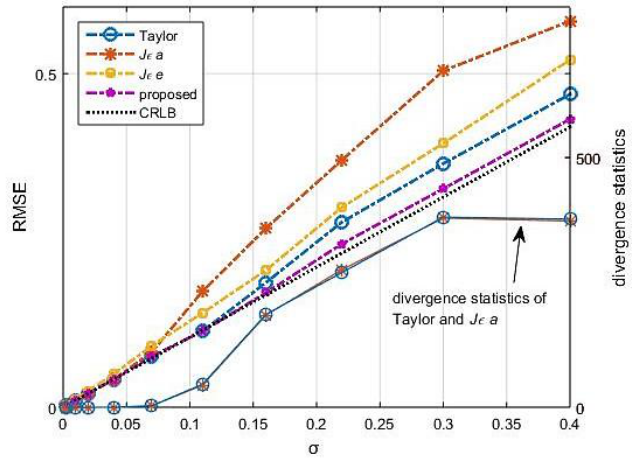
Figure 13. RMSE and the divergence times along the error changing, p = (1.2, 0.8) T .